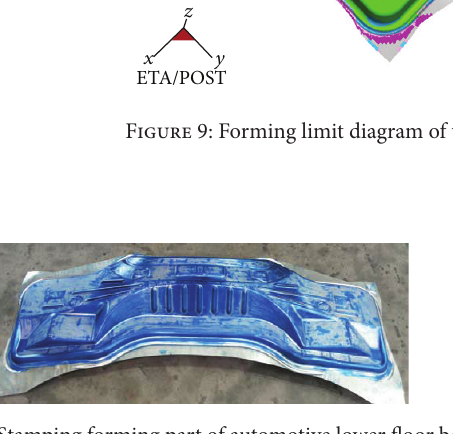
Figure 10: Stamping forming part of automotive lower floor board. Figure 11: The final product part of automotive lower floor